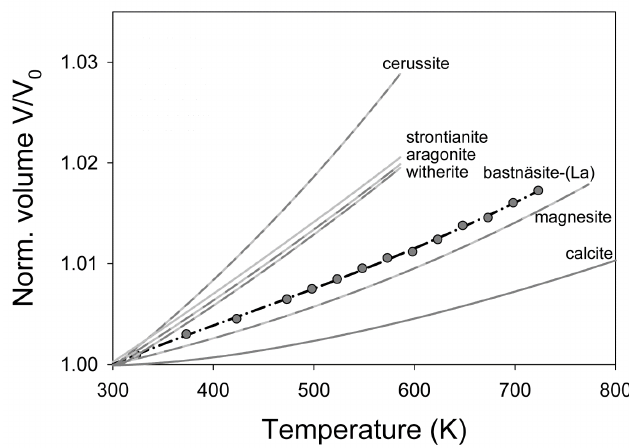
Figure 10. Comparisons of ambient pressure thermal equations of state for different carbonate minerals. Gray circles represent bastnäsite-(La) data from this study, and the dotted black line represent the fitted Fei equation of state [40] for bastnäsite-(La). Thermal equations of state are shown for calcite (CaCO 3 ), magnesite (MgCO 3 ) [43], witherite (BaCO 3 ), cerrusite (PbCO 3 ), strontianite (SrCO 3 ), and aragonite (CaCO 3 ) [42].